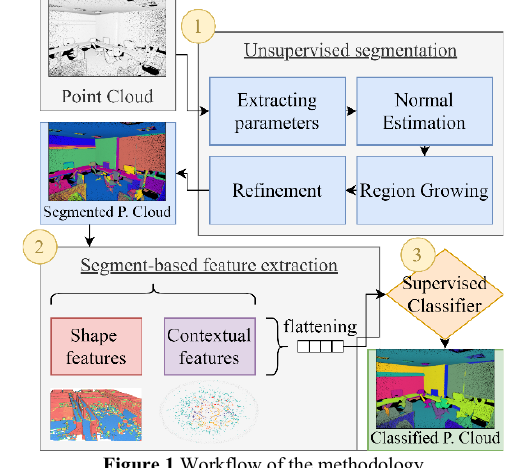
Figure 1 Workflow of the